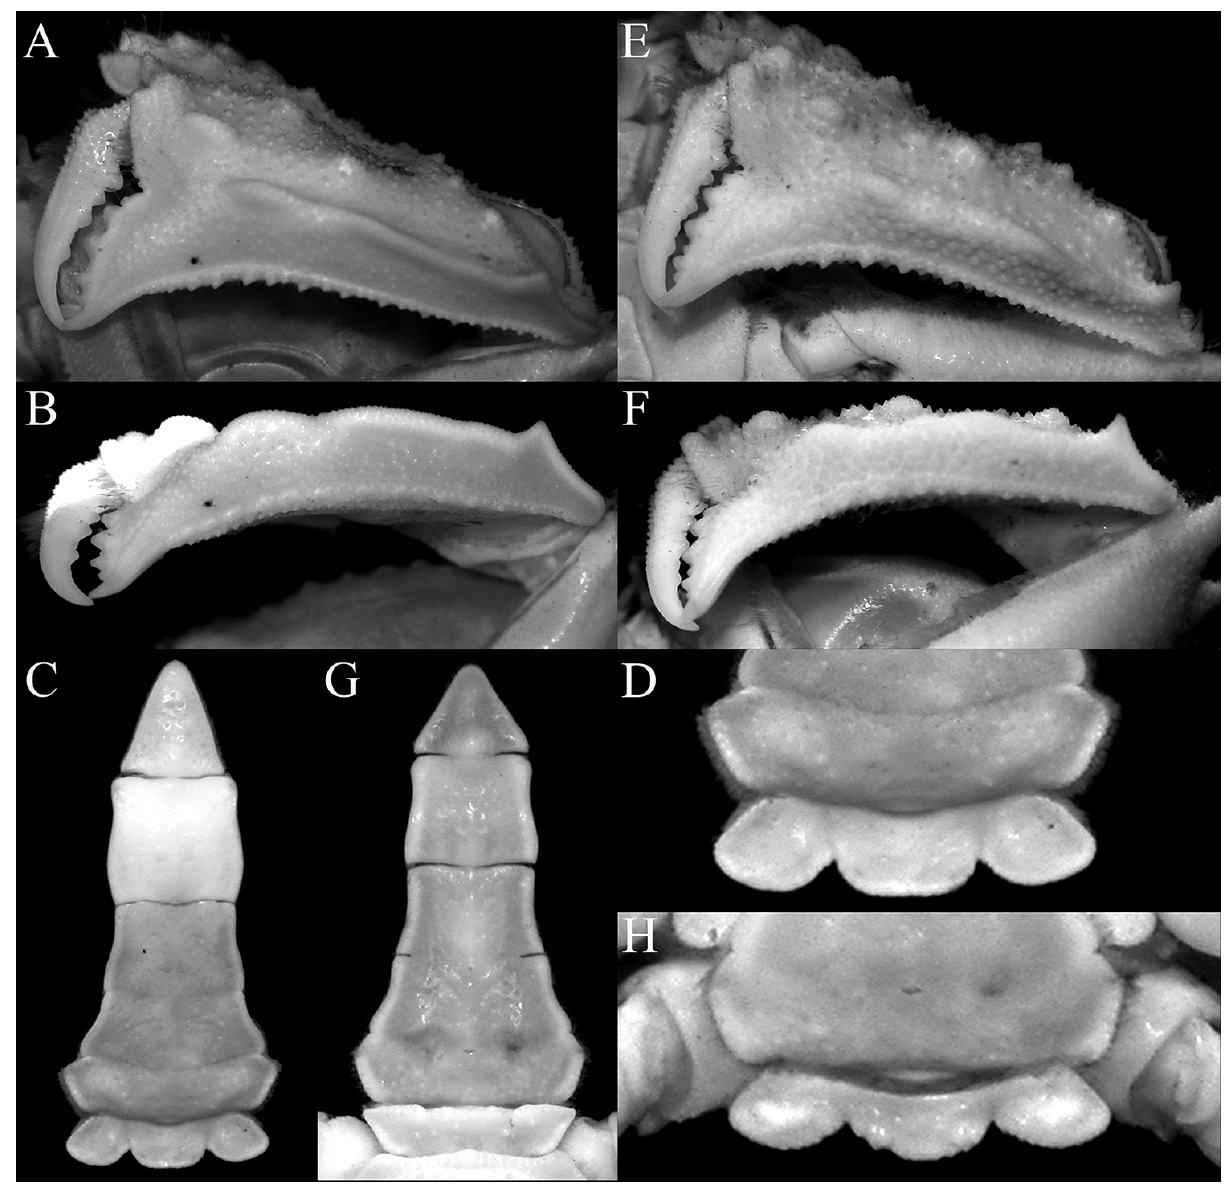
Figure 3. A – D , Mursia bicristimana Alcock and Anderson, 1894, young male (37.2 × 19.6 mm) (ZRC 2017.0134); E – H , M. spiridonovi Karasawa, 2018, male (23.9 × 14.6 mm) (ZRC 2019.0492). A , E , outer view of left chela; B , F , subventral view of left chela; C , G , pleon; D , H , pleonal somites 2 and